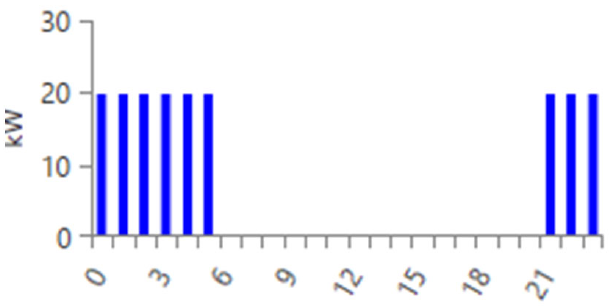
Figure 4. Daily load profile.